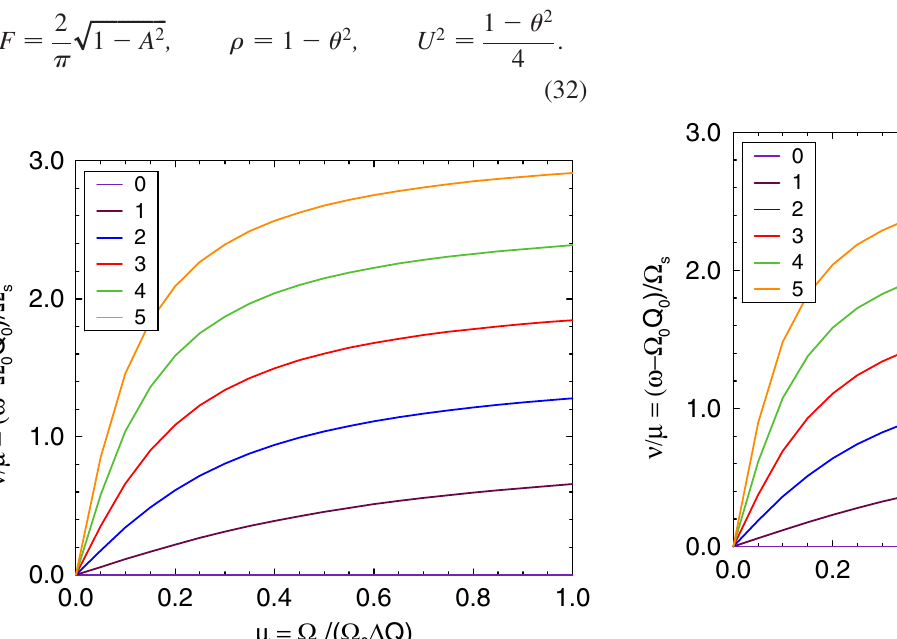
FIG. 5. (Color) Normalized eigenvalues of the ‘‘superparabolic’’ bunch.